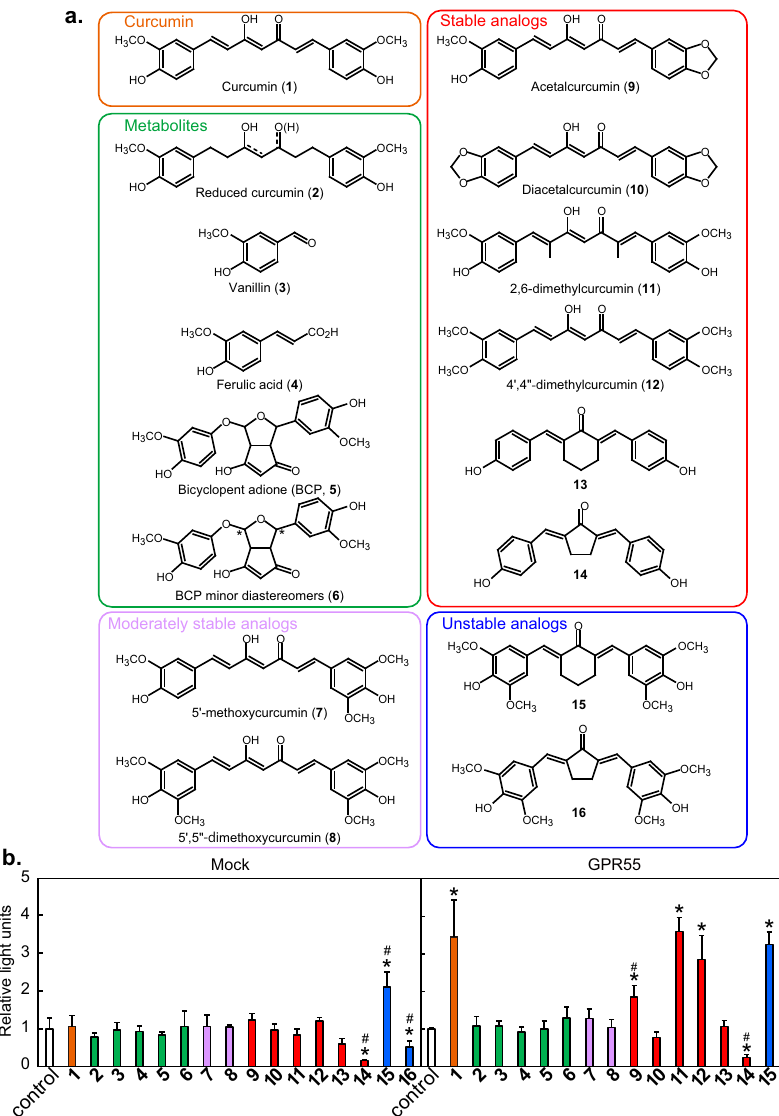
Fig. 3 Structure – activity relationship of GPR55 activation by curcumin and curcumin-related compounds. a Chemical structures of curcumin metabolites, moderately stable analogs, stable analogs, and unstable analogs. b HEK293-FT cells transfected with the GPR55 expression vector, p3xSRE-TATA-Luc2P, and pGL4.74[ hRluc /TK] were stimulated with each compound at 10 µM and reporter assay was performed. Data were expressed as the mean ± s.d. ( n = 4). Statistical analysis was performed on each of the wells transfected with the mock vector or the GPR55 expression vector. * p < 0.05 vs control; # p < 0.05 vs . both control and compound 1